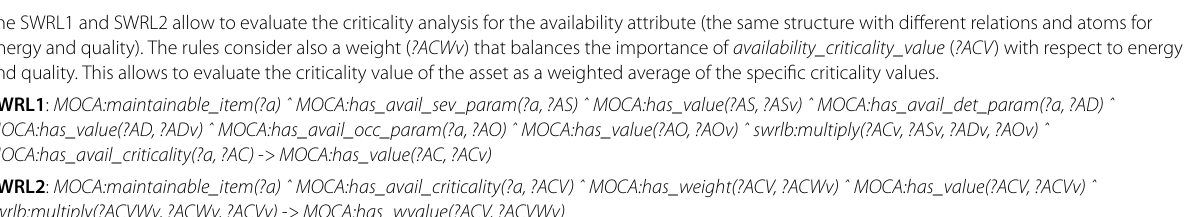
Table 1 SWRL rules implemented in MOCA SWRL